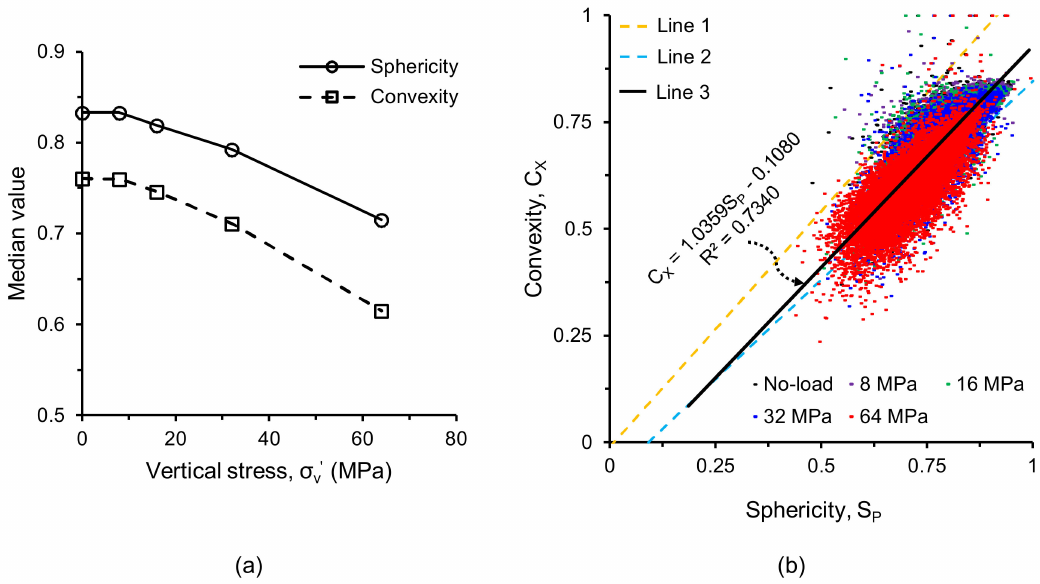
Figure 11. ( a ) Median values of shape parameters of RBS particles at different vertical stresses, ( b ) Correlation between sphericity and convexity of RBS particles (Line 1—Zhao et al. [35], Line 2—Fonseca et al. [36], Line 3—this